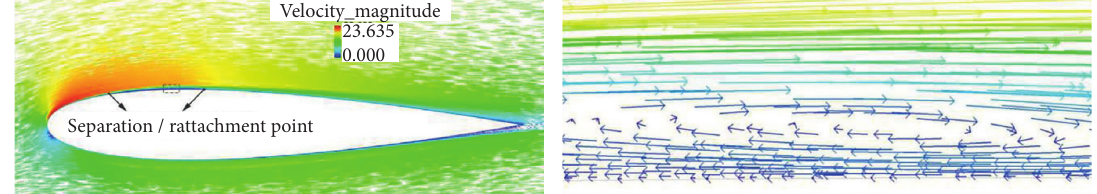
Figure 6. Profile of the velocity field in Re c = 2.38 × 10 5 and AoA = 3 with extended detail.